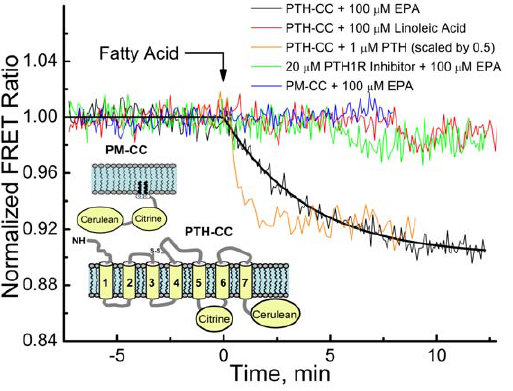
Figure 5. Response of PTH-CC FRET sensor and PM-CC (control FRET sensor) to stimulation by PTH, EPA, EPA and PTH1R inhibitor, [Nle 8,18 ,Tyr 34 ]PTH(3–34), or linoleic acid. Experiments were done 24 h after transfection of PTH-CC FRET sensor or PM-CC, in HEK293 cells in chambered cover glass at 37 u C. FRET ratio was defined as ratio of Citrine emission intensity at 525 nm to Cerulean emission intensity at 475 nm. The FRET response to PTH is from [50].